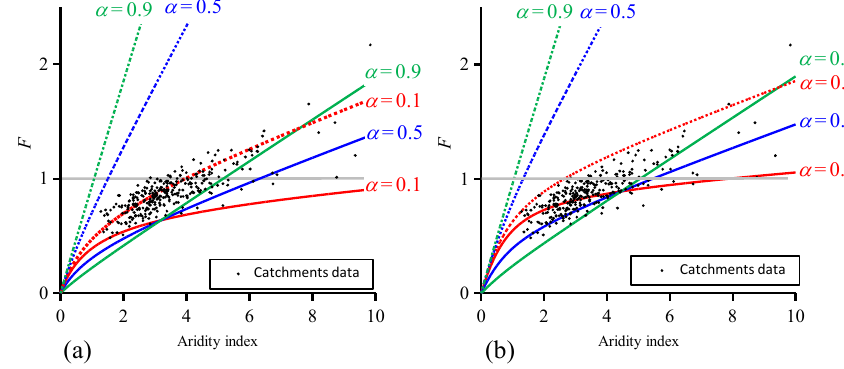
Figure 9. The typical F − ϕ curves for annual water balance in the standard Budyko space determined with Eq. (22) when w = 1.5 (a) and w = 2.0 (b) . The solid and dashed curves are estimated using gG a = 0.2 and gG a = 1.0, respectively. Dots are the data points of the study